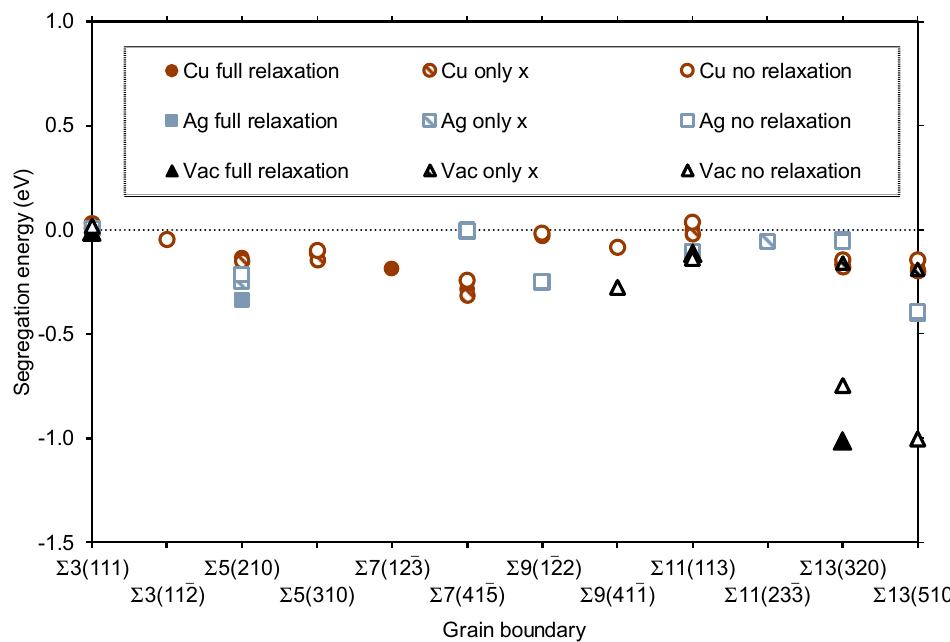
Figure 4. The segregation energy E segr in eV of single Cu Pd , Ag Pd , and V Pd defects for the various GBs. E segr is shown for Cu (red circles), Ag (blue squares), and vacancy (black triangles) segregation, using full volume relaxation (filled symbols), relaxation along the x direction only (half-filled symbols), and no volume relaxation (open symbols). Only well-defined energies are included (see text).